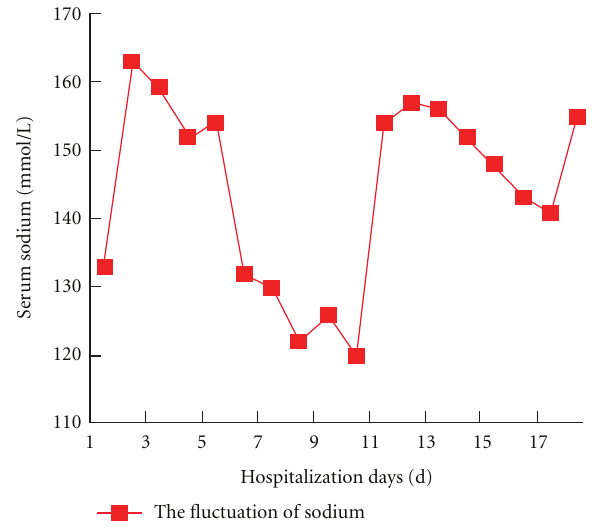
Figure 2: The line graph showed the serum sodium concentration changing with the postoperative time.